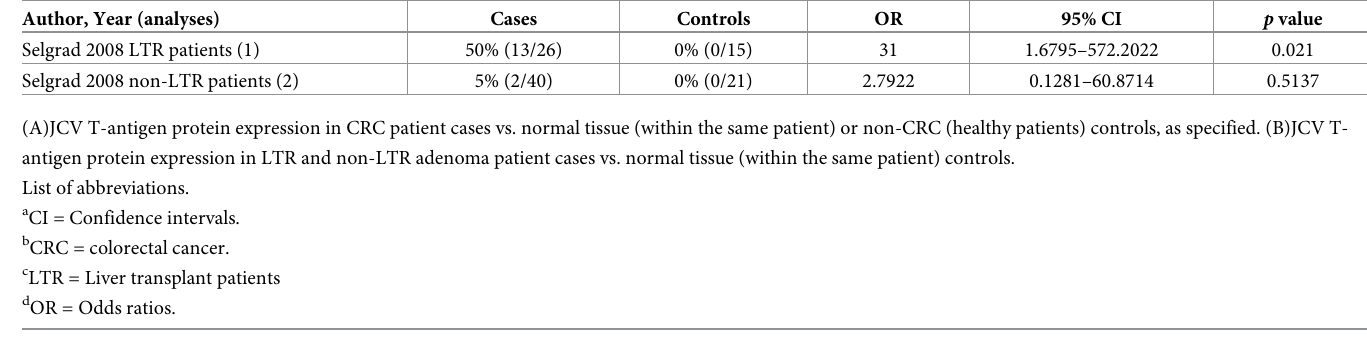
Goel 2006 distal normal site controls 2B: Adenoma cases vs. controls of matched adjacent normal tissue